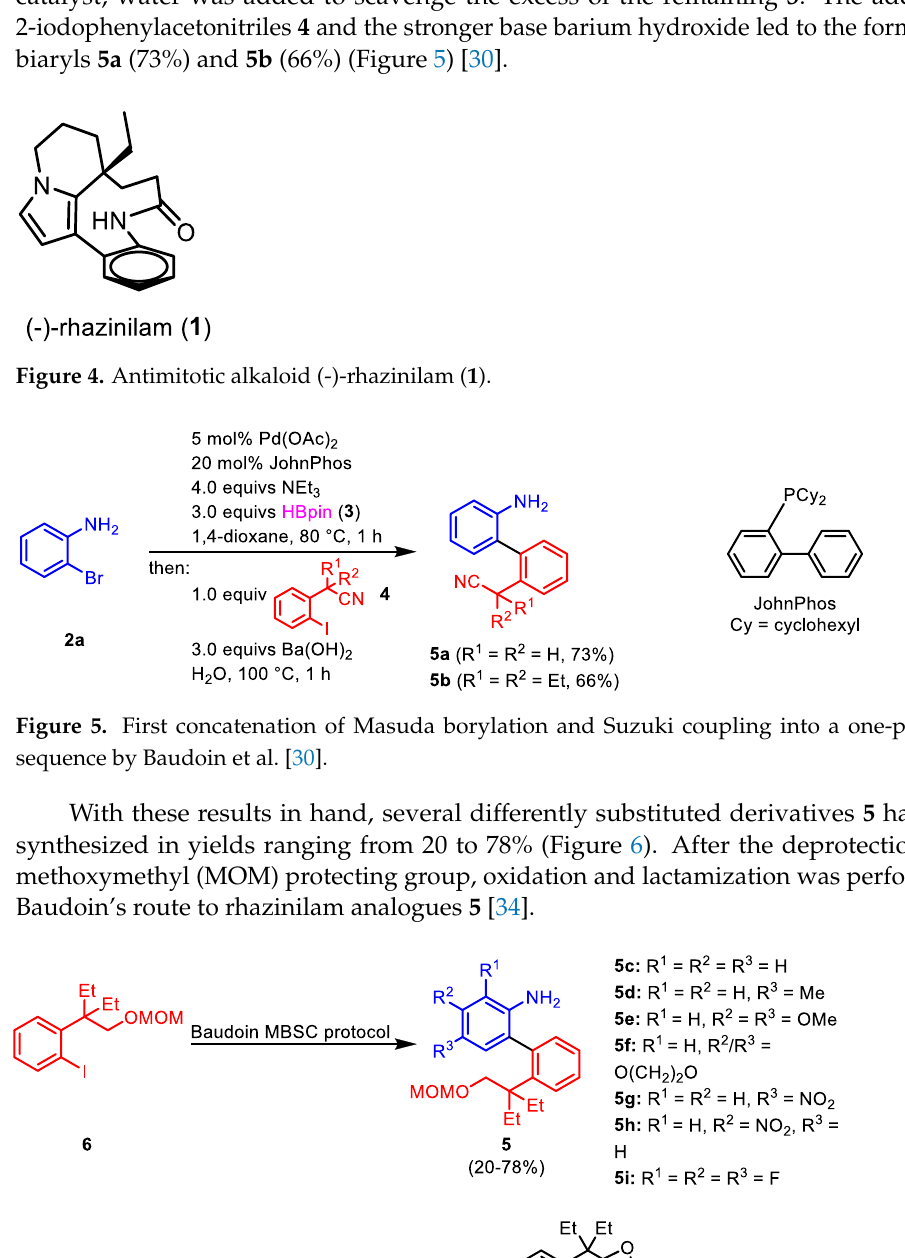
Figure 5. First concatenation of Masuda borylation and Suzuki coupling into a one-pot MBSC se- Figure 6. Synthesis of analogues of rhazinilam 5 via Baudoin’s one -pot MBSC protocol [34]. Figure 6. Synthesis of analogues of rhazinilam 5 via Baudoin’s one-pot MBSC protocol [34]. quence by Baudoin et al. [30].